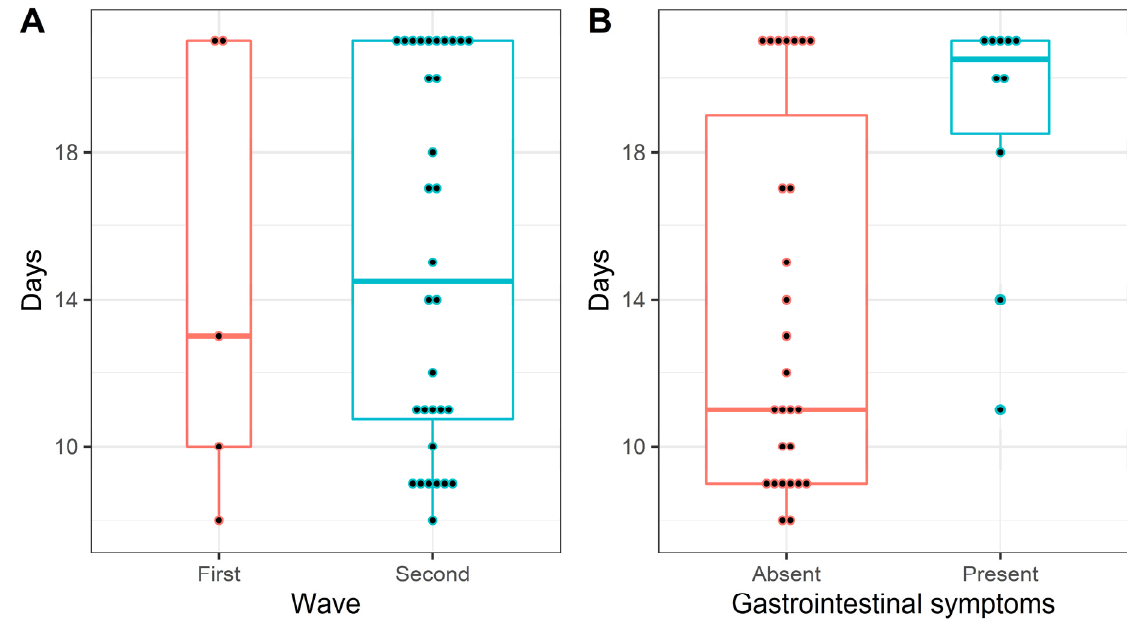
Figure 2. Boxplot and stacked dot-plot (one dot each patient) for days until negative swab across the first two COVID-19 waves ( A ) and according to presence of gastro-intestinal symptoms ( B ). From day 21, everyone is considered as having a negative swab. The boxes report I, II (median), and III quartiles, whiskers extend at most 1.5*Inter-Quartile range from the hinges.